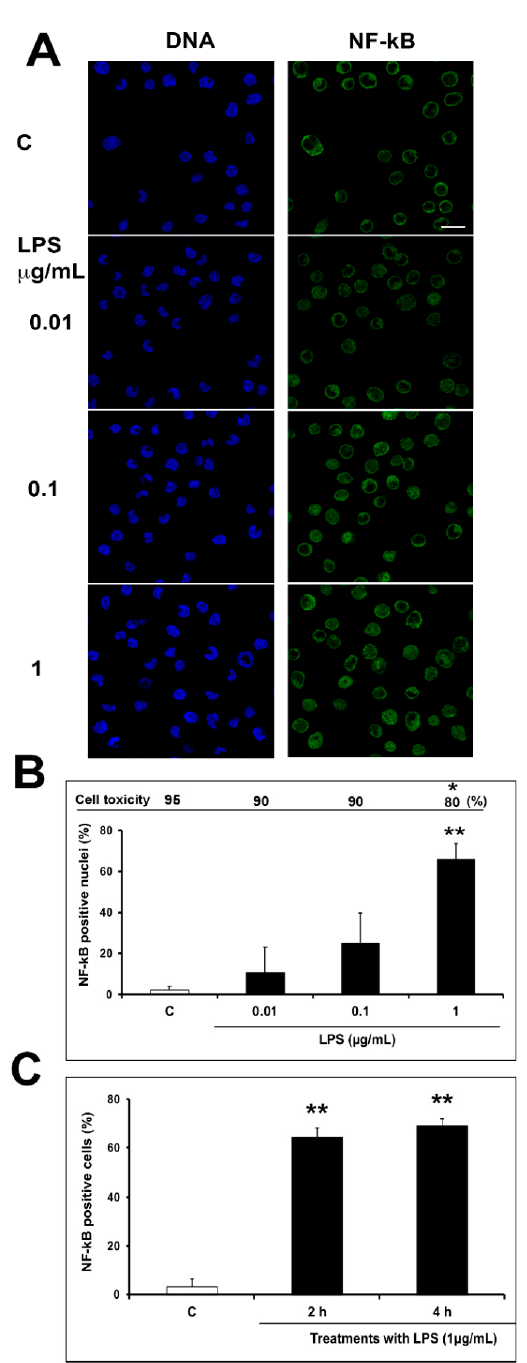
Figure 3. Optimization of LPS concentrations for NF-kB activation in THP1 cells. ( A ) NF-kB representative images obtained after immunostaining of THP1 cells treated with di ff erent concentrations of LPS and ( B ) the relative quantification of NF-kB-stained positive cells. Nuclear translocation of NF-kB was determined by immunofluorescence microscopy using antibody directed against p65 subunit. Cell toxicity was evaluated by Trypan blue assay, after treatment with LPS at the di ff erent concentrations. ( C ) NF-kB activation after 2 and 4 h of treatment with 1 µ g / mL LPS. Scale bar = 20 µ m. All results are expressed as mean ± SD from three independent experiments. ** p ≤ 0.01 by Student’s t -test.